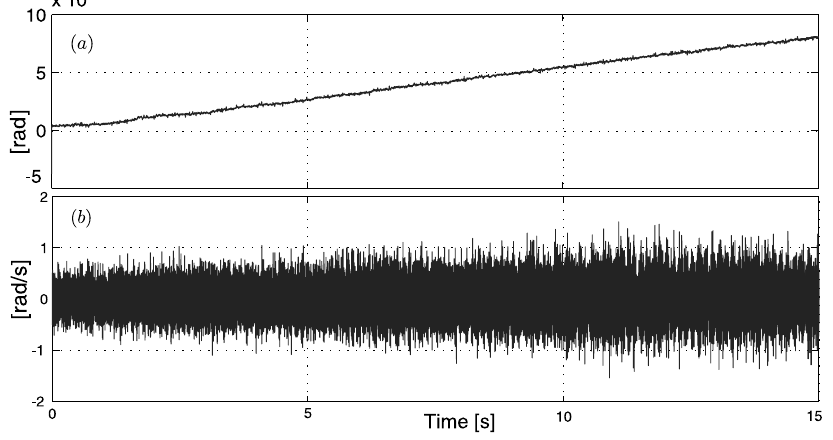
Fig. 8. (a) Angle of attack; (b) Lateral speed of the wheel above the contact